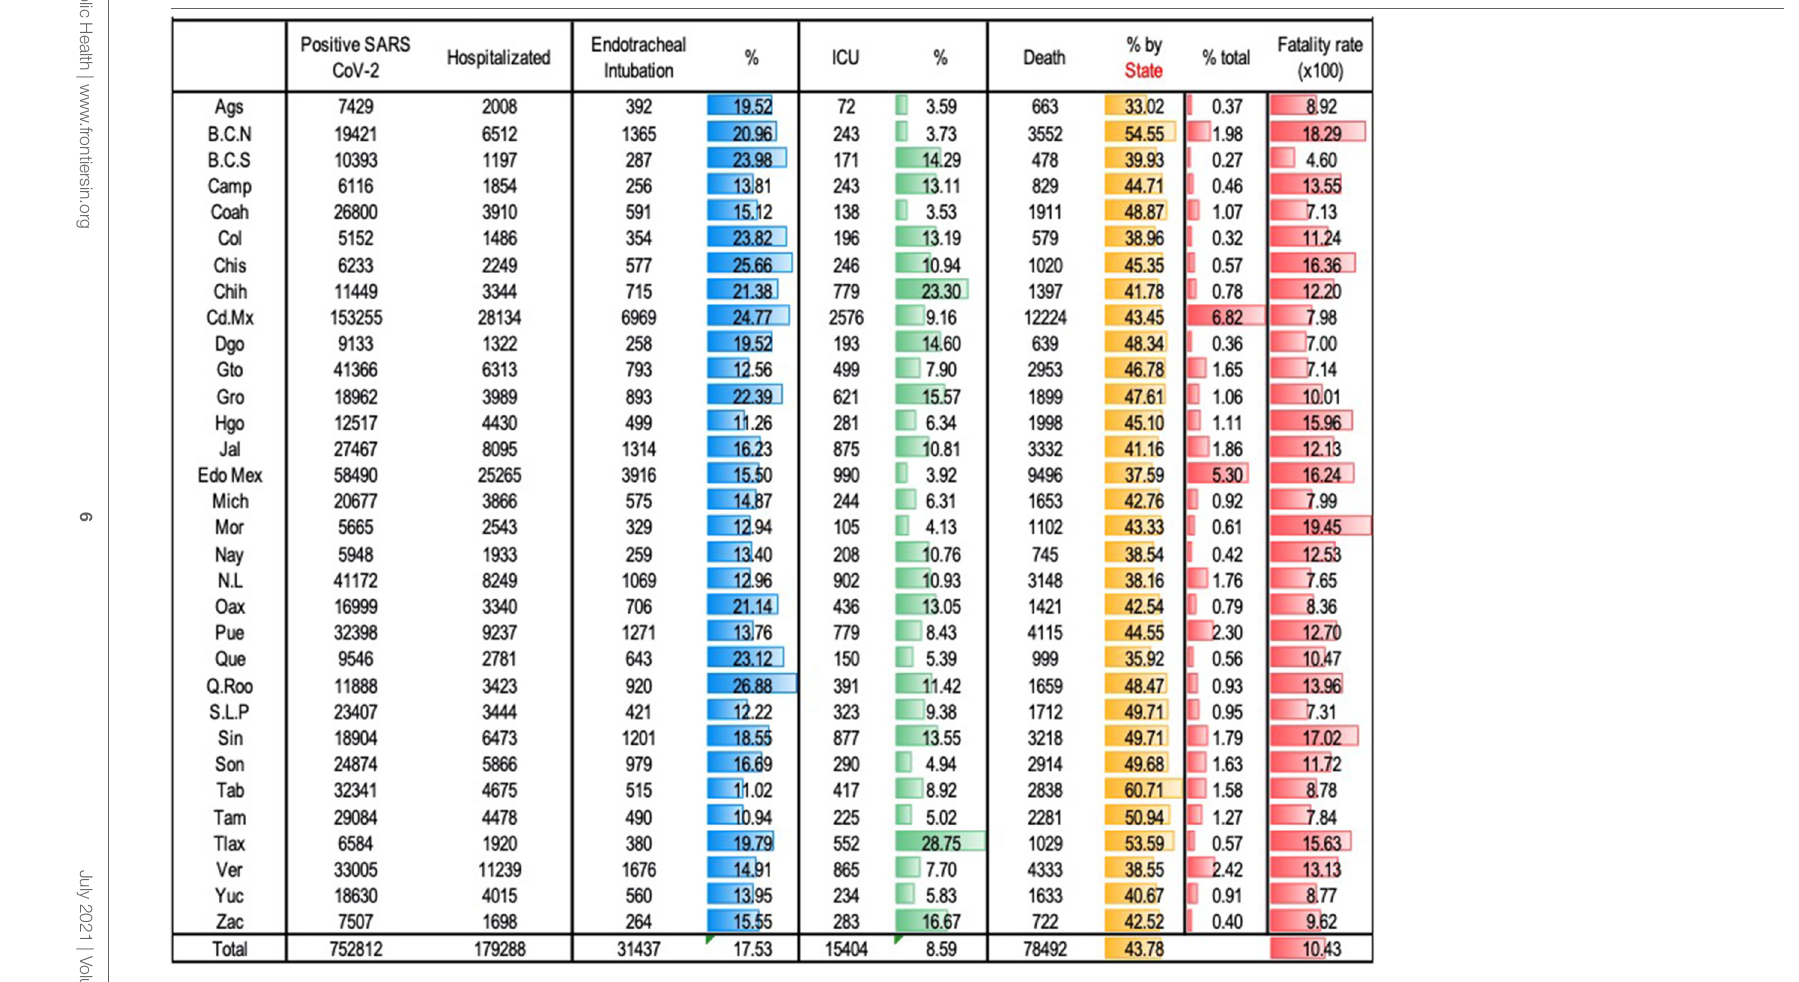
TABLE 3 | Hospitalization, ICU care, endotracheal intubation, and fatality by State.